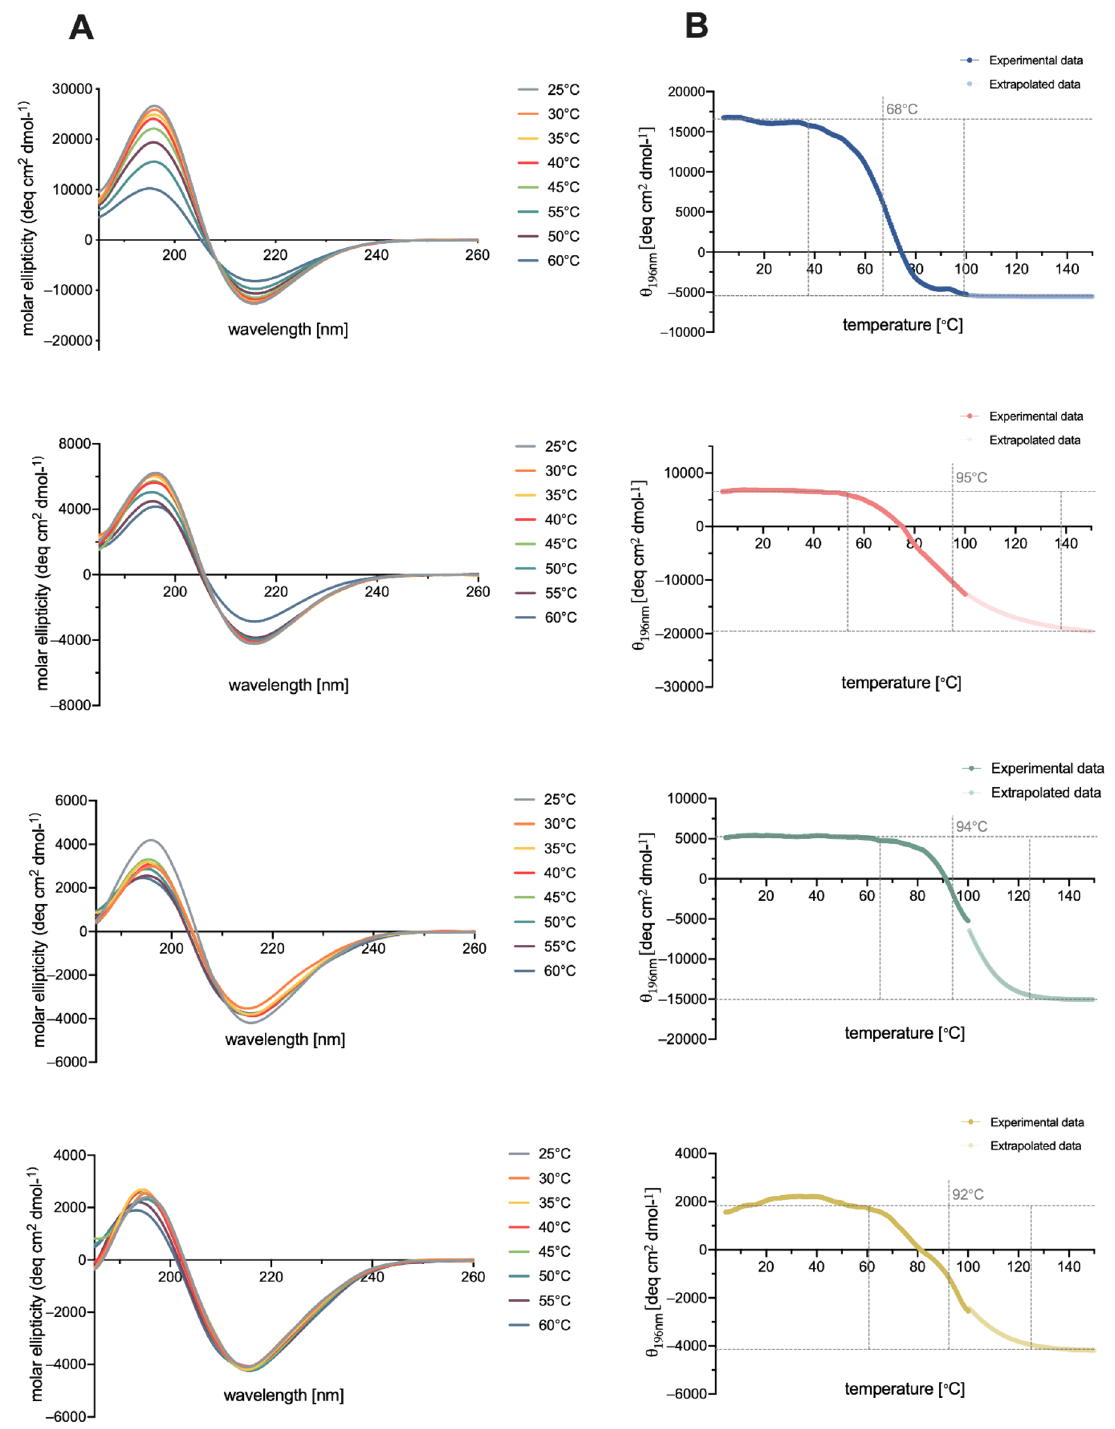
Figure 3. CD spectra of RADA peptides at 185–260 nm ( A ), and the effect of temperature on the CD spectra at constant 196 nm ( B